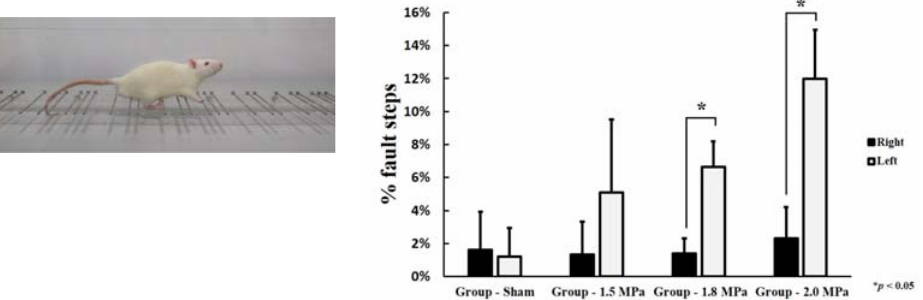
Figure 3. Horizontal ladder rung walking test. Statistical significance: * p ≤ 0.05 significant.